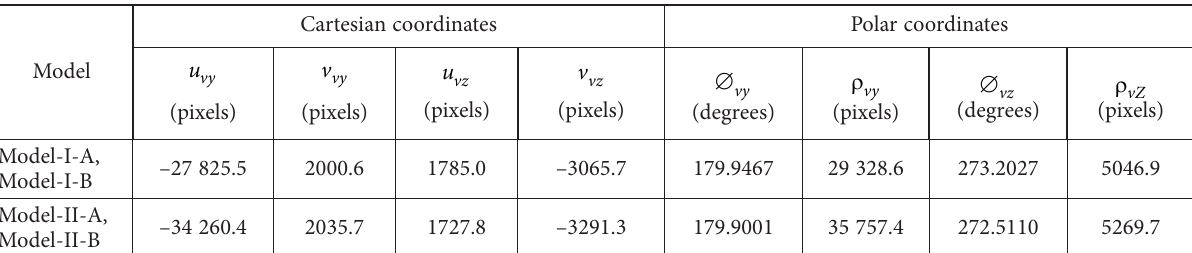
Table 5. Image cartesian and polar coordinates of vanishing points for